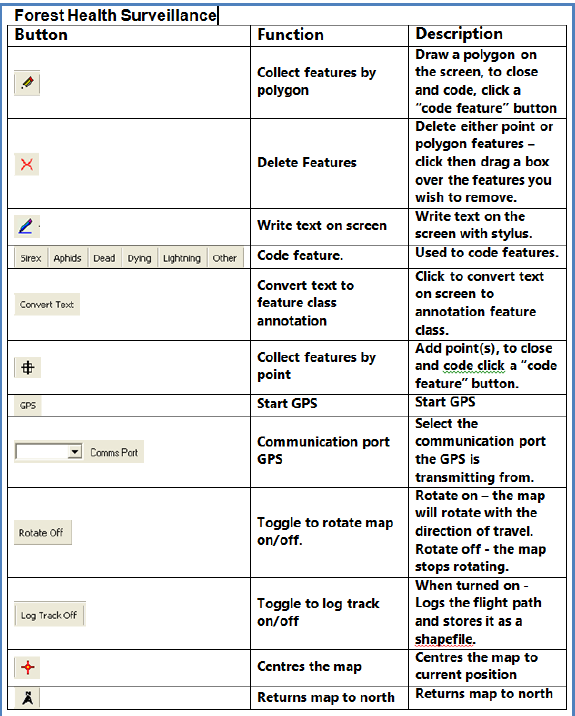
Figure 1. Data capture with the Forest Health Monitoring system